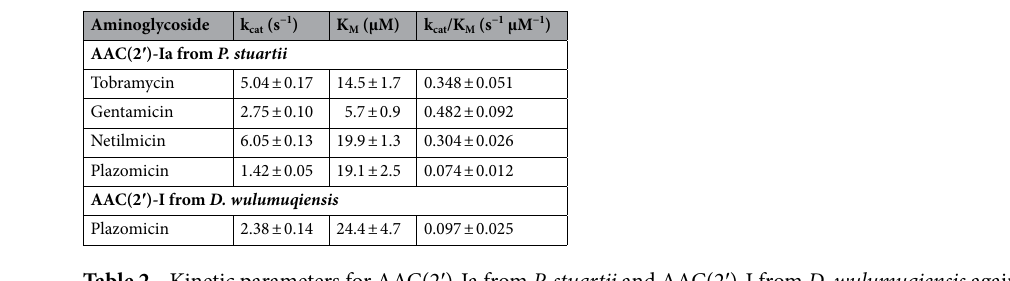
Table 2. Kinetic parameters for AAC(2 ′ )-Ia from P. stuartii and AAC(2 ′ )-I from D. wulumuqiensis against